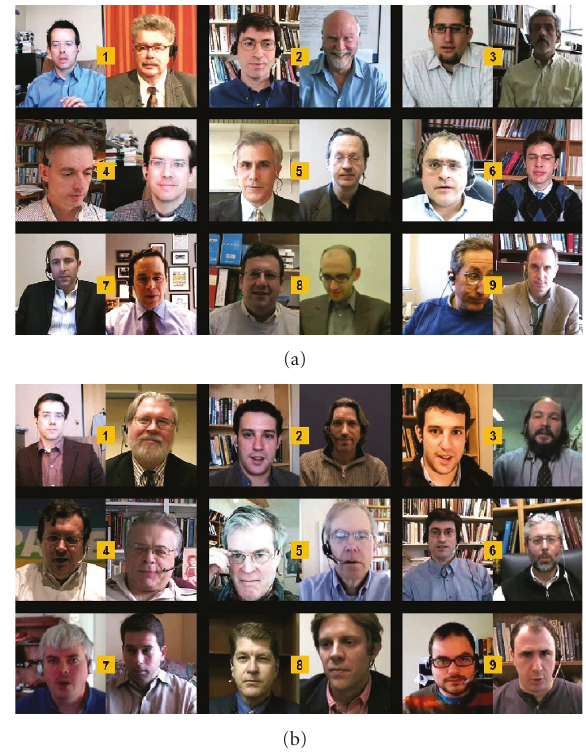
Figure 6: Mosaics of dyadic